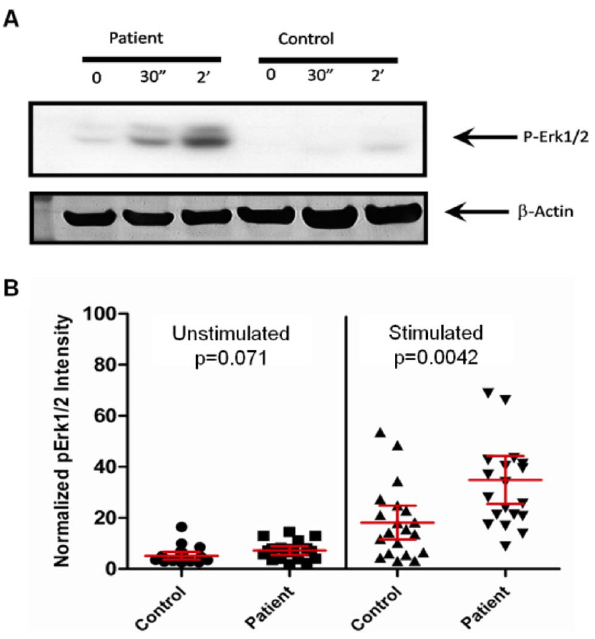
Figure 1. pERK1/2 is upregulated in hyperresponsive B cells after stimulation. B cells isolated from SLE patients and matched controls were stimulated with anti-human IgM F(ab)’ 2 for 30 seconds or 2 minutes. pERK1/2 (A) and normalized pERK1/2 intensity (B) shows increase in hyperresponsive B cells after stimulation.